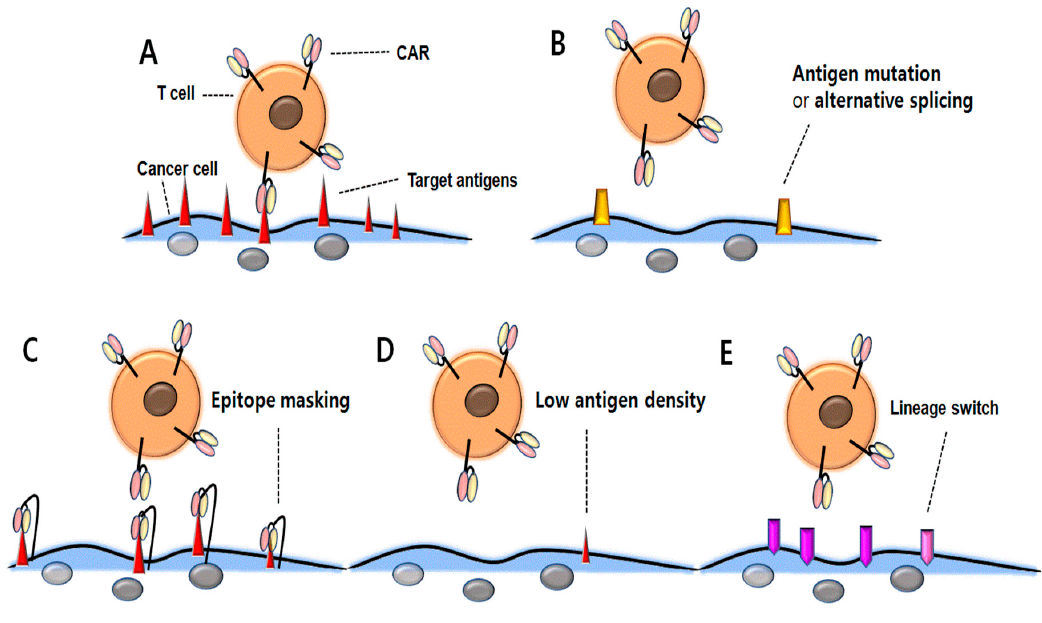
Figure 1. Resistance mechanisms associated with antigen loss following CD19 CAR T-cell therapy. ( A ) CAR T-cells bind with tumor-associated antigens and represent antitumor activity. ( B ) Due to CD19 CAR mutations or alternative splicing, CAR T-cells cannot bind the antigens and therefore, cancer cells may be resistant to therapy. ( C ) Due to CD19 CAR binding to CD19 antigen and subsequent masking of the CD19 epitope, CAR T-cells cannot attack the cancer cells. ( D ) Down-regulated antigen